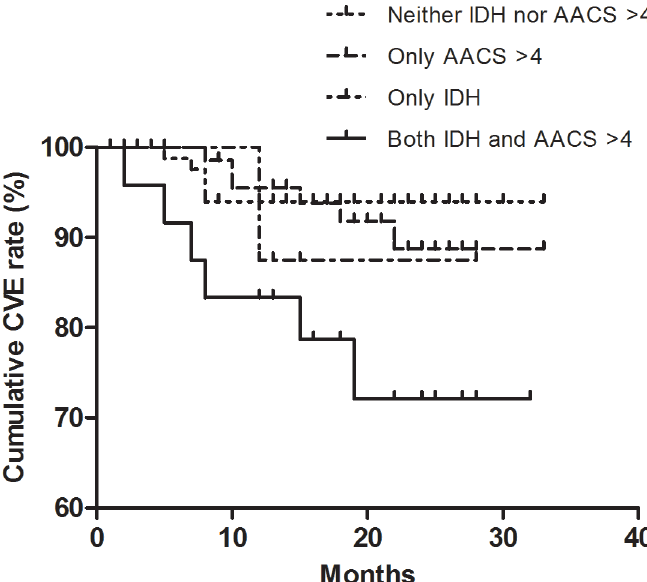
Fig 1. Cumulative rates of cardiovascular event. IDH, intradialytic hypotension; AACS, abdominalaortic calcification score.